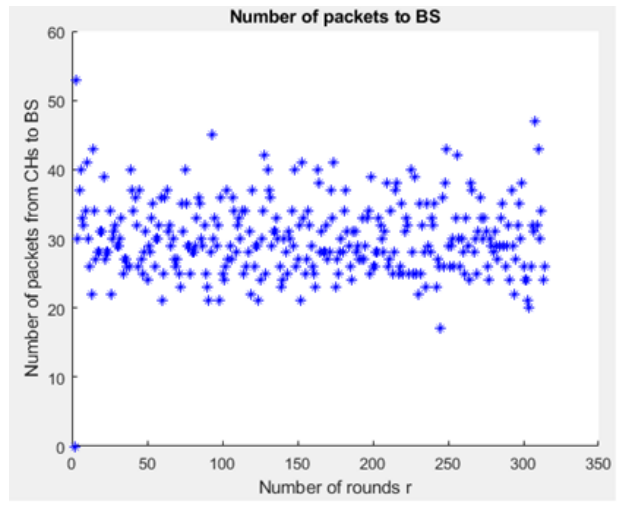
Figure 33. Number of packets per round r in NB-IoT D2D attocell